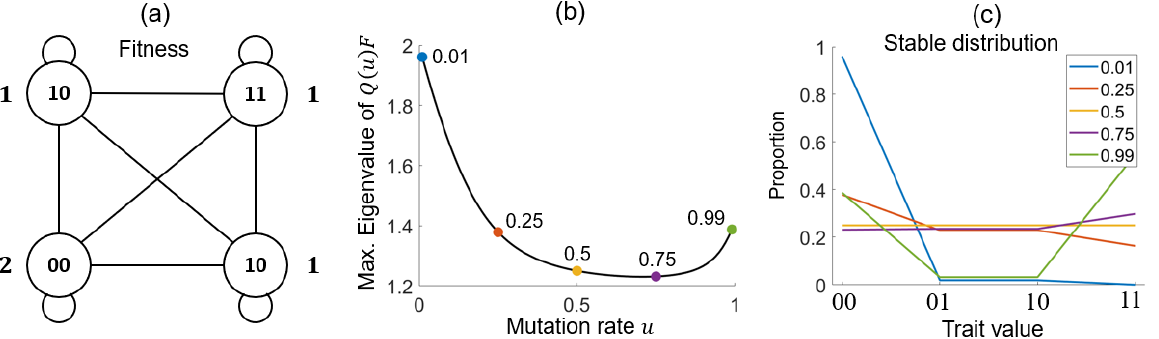
Figure 2. For the given fitness function ( a ), we see that mutation is eventually favored, and the maximum eigenvalues increase with mutation rate ( b ). Panel ( c ) shows that the stable distribu- tions corresponding with the points of the same color in ( b ) flatten with increasing mutation, then become